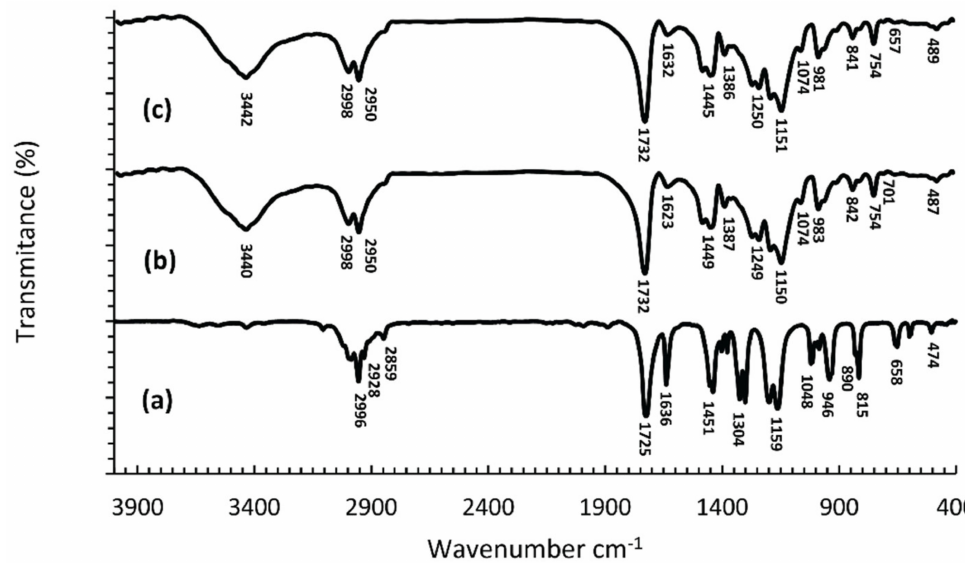
Figure 1. FTIR spectra of: MMA monomers ( a ), cold-curing PMMA polymers ( b ), and polymerized mixtures of monomers and cold-curing PMMA polymers ( c ).